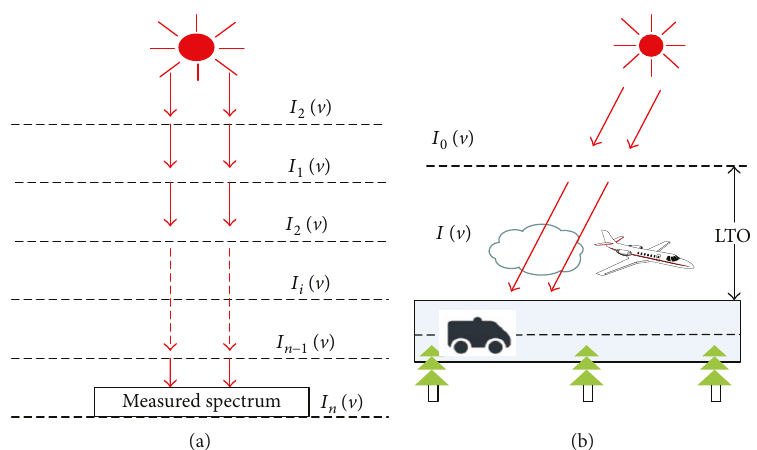
Figure 3: Atmospheric transmission model: (a) multilayer atmospheric transmission model and (b) two-layer atmospheric transmission